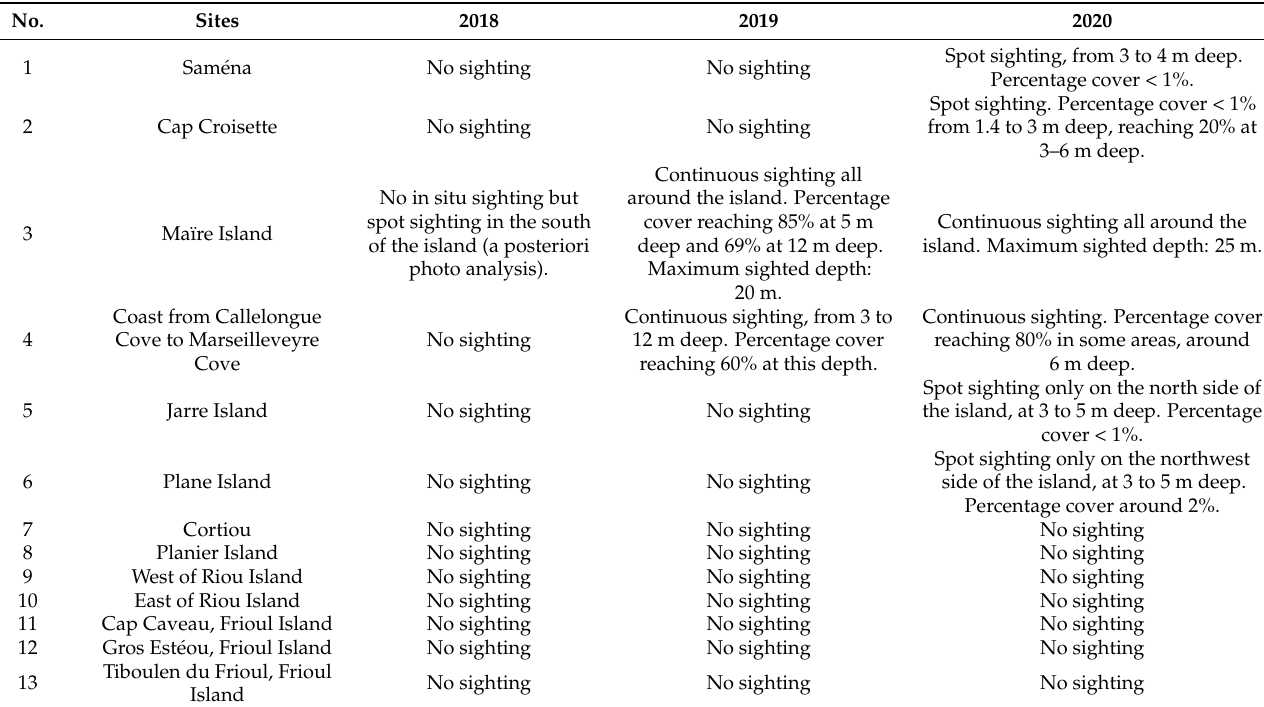
Table 1. Rugulopteryx okamurae presence and the main characteristics of distribution (% cover, depth) at the study sites. See Figure 1 for the locations of the sites with their number